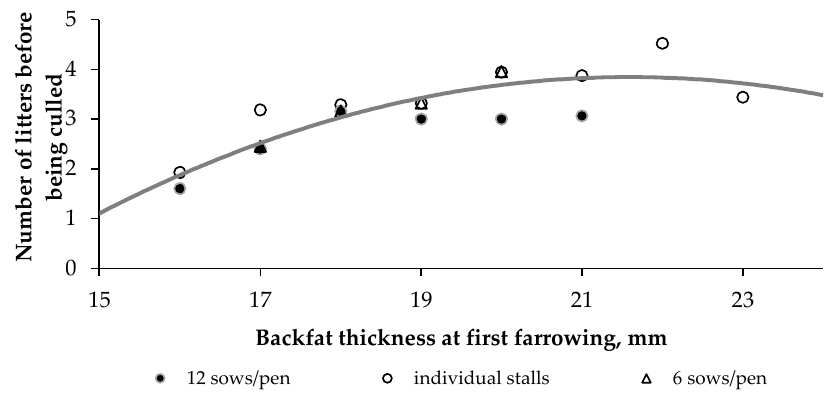
Figure 1. Relationship between mean backfat thickness measured at first farrowing and mean longevity (i.e., number of litters farrowed before being culled from the herd) for sows housed in individual stalls or in pens containing 6 or 12 sows (from cycles 20–39, 720 primiparous sows, each dot represents at least 20 sows). Table 1. Mean performance at birth and during lactation by class of backfat thickness at farrowing (BT final ). BT final class, mm ≤ 14 15 – 17 18 – 20 21 – 23 ≥ 24 RSD 1 p-Value 2 Number of sows